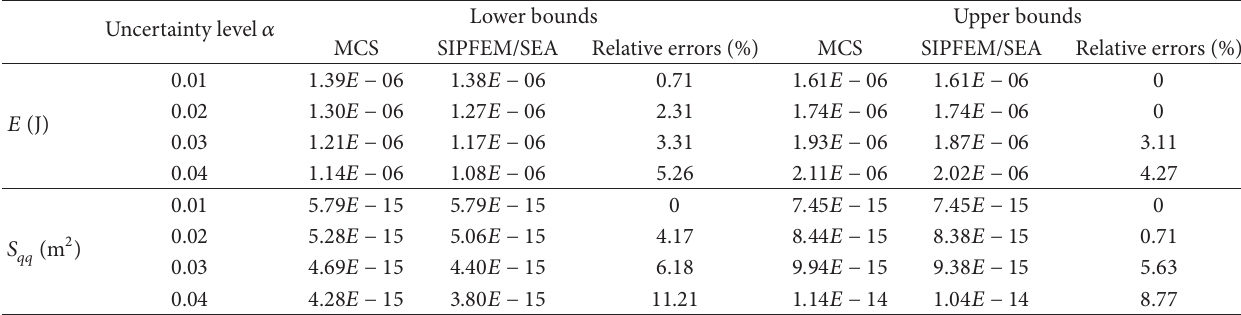
levels ( 𝑓 = 440 Hz).